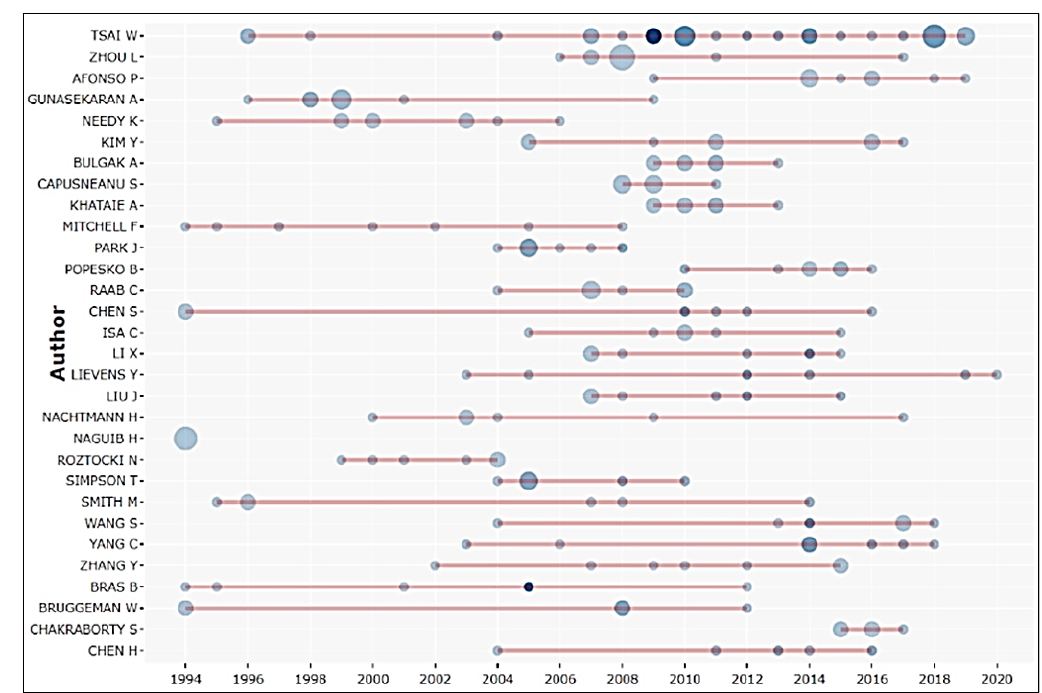
J. Open Innov. Technol. Mark. Complex. 2021 , 7 , x FOR PEER REVIEW Figure 3. Authors production over Time in ABC domain. Figure 3. Authors production over Time in ABC domain.